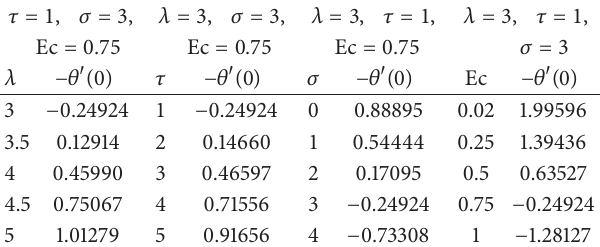
Table 4: The local Nusselt number −𝜃 󸀠 (0) for different values of 𝜆, 𝜏, 𝜎 , and Ec (𝐾 = 2, Pr = 0.733) .